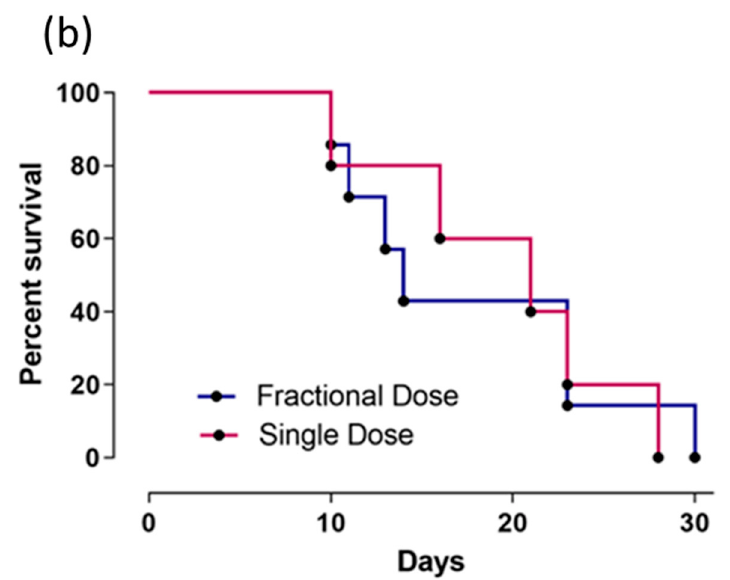
Figure 5. ( a ) Plot of tumor data showing means of tumor volume for each group with standard deviations as error bars (above). ( b ) Kaplan–Meier curves for survival data of FD (fractional dose) and SD (single dose) were recorded up to 30 days. The data are statistically nonsignificant.